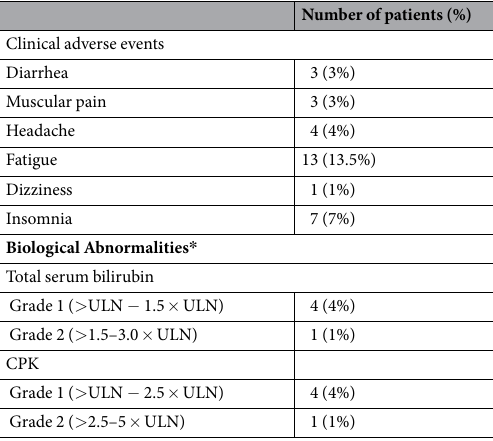
Table 2. Clinical adverse events and biological abnormalities reported in our cohort of 96 patients. * Grade